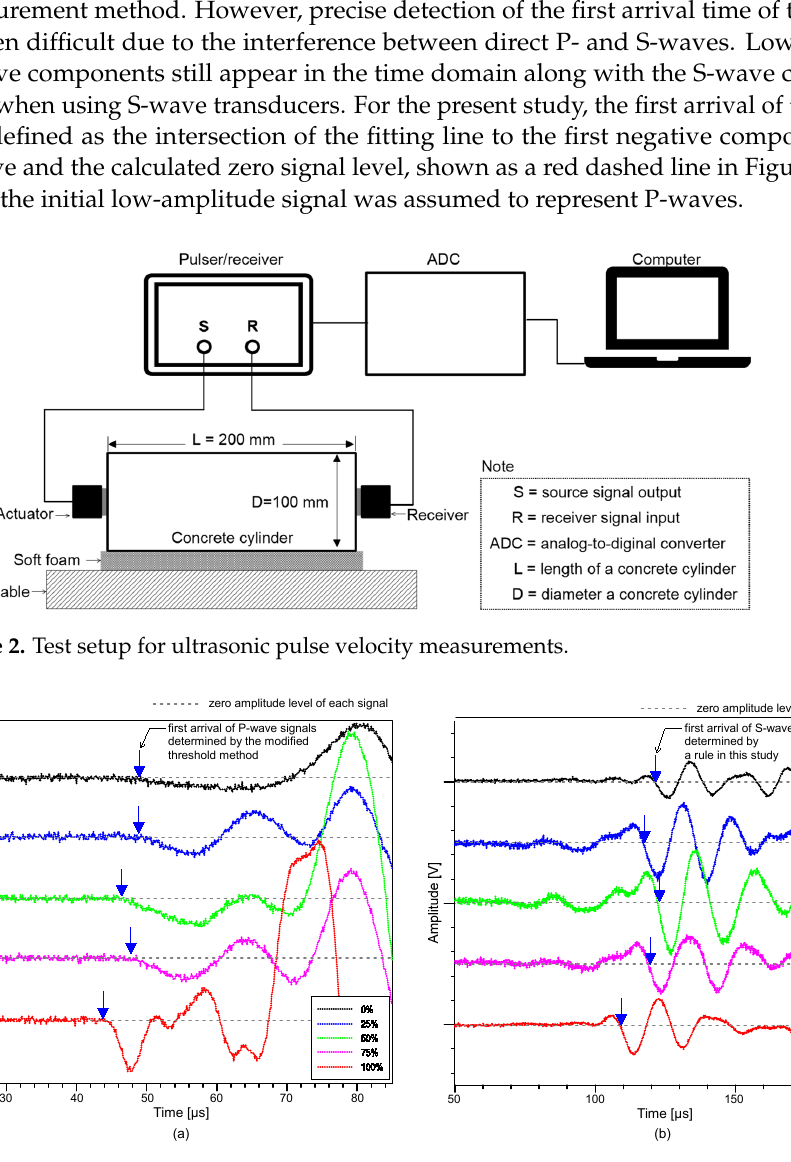
Figure 4. Test setup of electrical resistivity measurements of concrete: ( a ) four-point Wenner probe configuration, with an equal distance (=38 mm) between the electrodes, and ( b ) A-A section view of the Wenner probe configuration in Figure 4a. 2.1.4. Measurement of Mechanical Properties After measuring the three NDE parameters (P- and S-wave velocities and ER), the compressive strength of the cylindrical specimens were measured using a 2000 kN uni- versal testing machine (UTM, KST, Busan, South Korea). The specimens were at the age of around 226 to 263 days at the time of testing. The compressive strengths were tested in accordance with ASTM C39/C39M-20 [77] under displacement control. Uniaxial